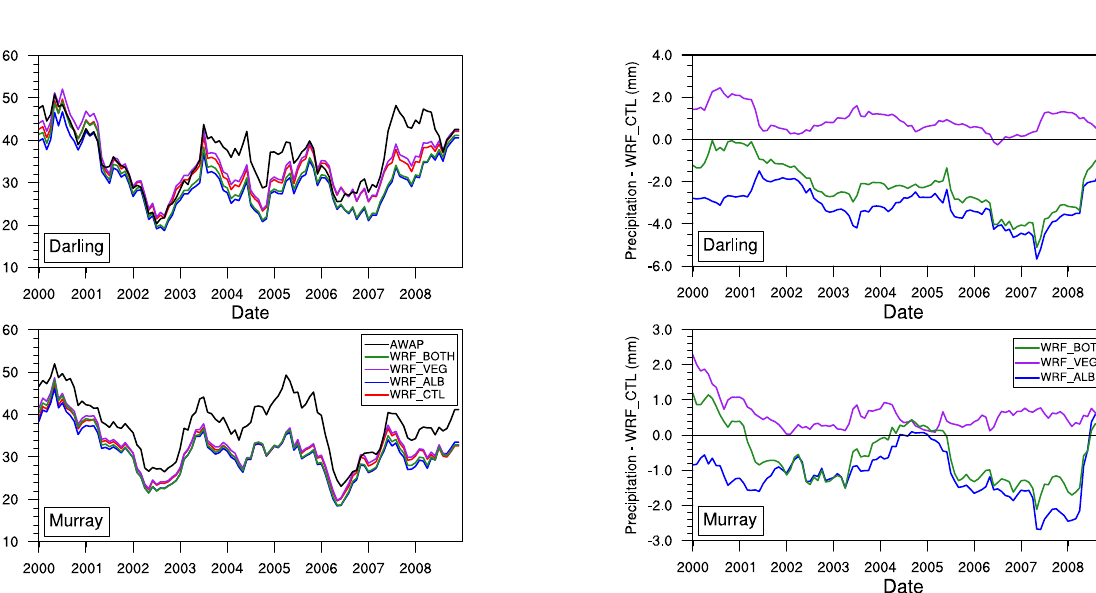
Figure 4. Annual precipitation and precipitation bias of each model simulation. The hue of the colours gives the bias in millimetres per month while the saturation/intensity gives the bias in percentage terms. Grey areas have less than 10% bias.